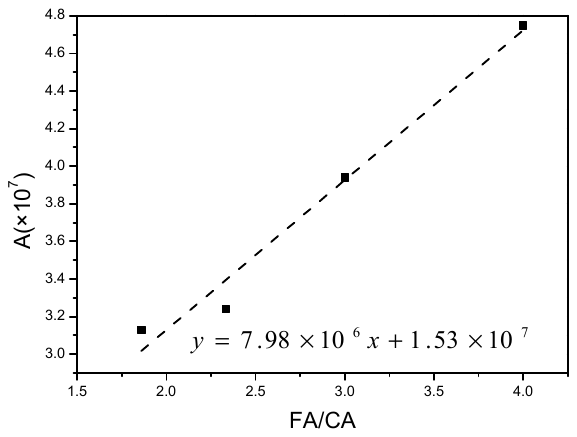
Figure 3. Linear relationship curve between A and FA/CA.